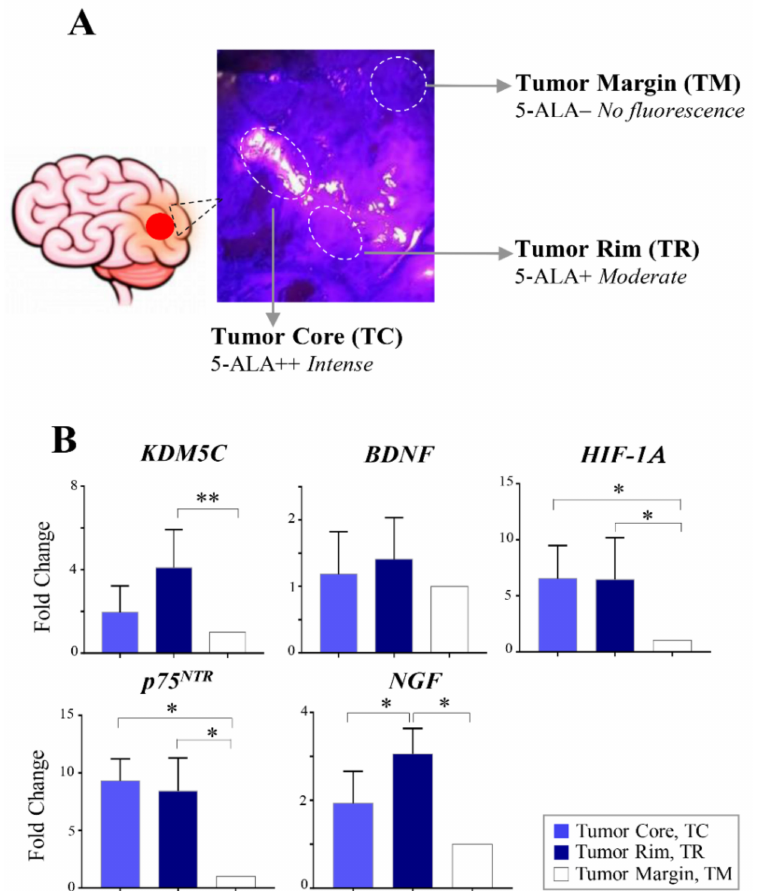
Figure 3. Expression analysis in GBM areas isolated by 5-aminolevulinic acid fluorescence-guided surgery. ( A ) Intraoperative photographs obtained in the GBM patient #45. 5-ALA administration showing the resection cavity illuminated with blue light, demonstrating intense and moderate 5-ALA fluorescence representing the tumor core and tumor rim, respectively. ( B ) RT-PCR analysis of the KDM5C , BDNF , HIF1A, p75 NTR , and NGF transcripts in different layers identified by 5-ALA surgery. Each transcript analysis was performed in triplicate, and the samples were normalized with the TATA-Box Binding Protein ( TBP ) gene. The bars indicate the mean ± SEM of repeated experiments. Asterisks indicate statistical significance compared with the healthy control samples: ** p < 0.005 and * p <